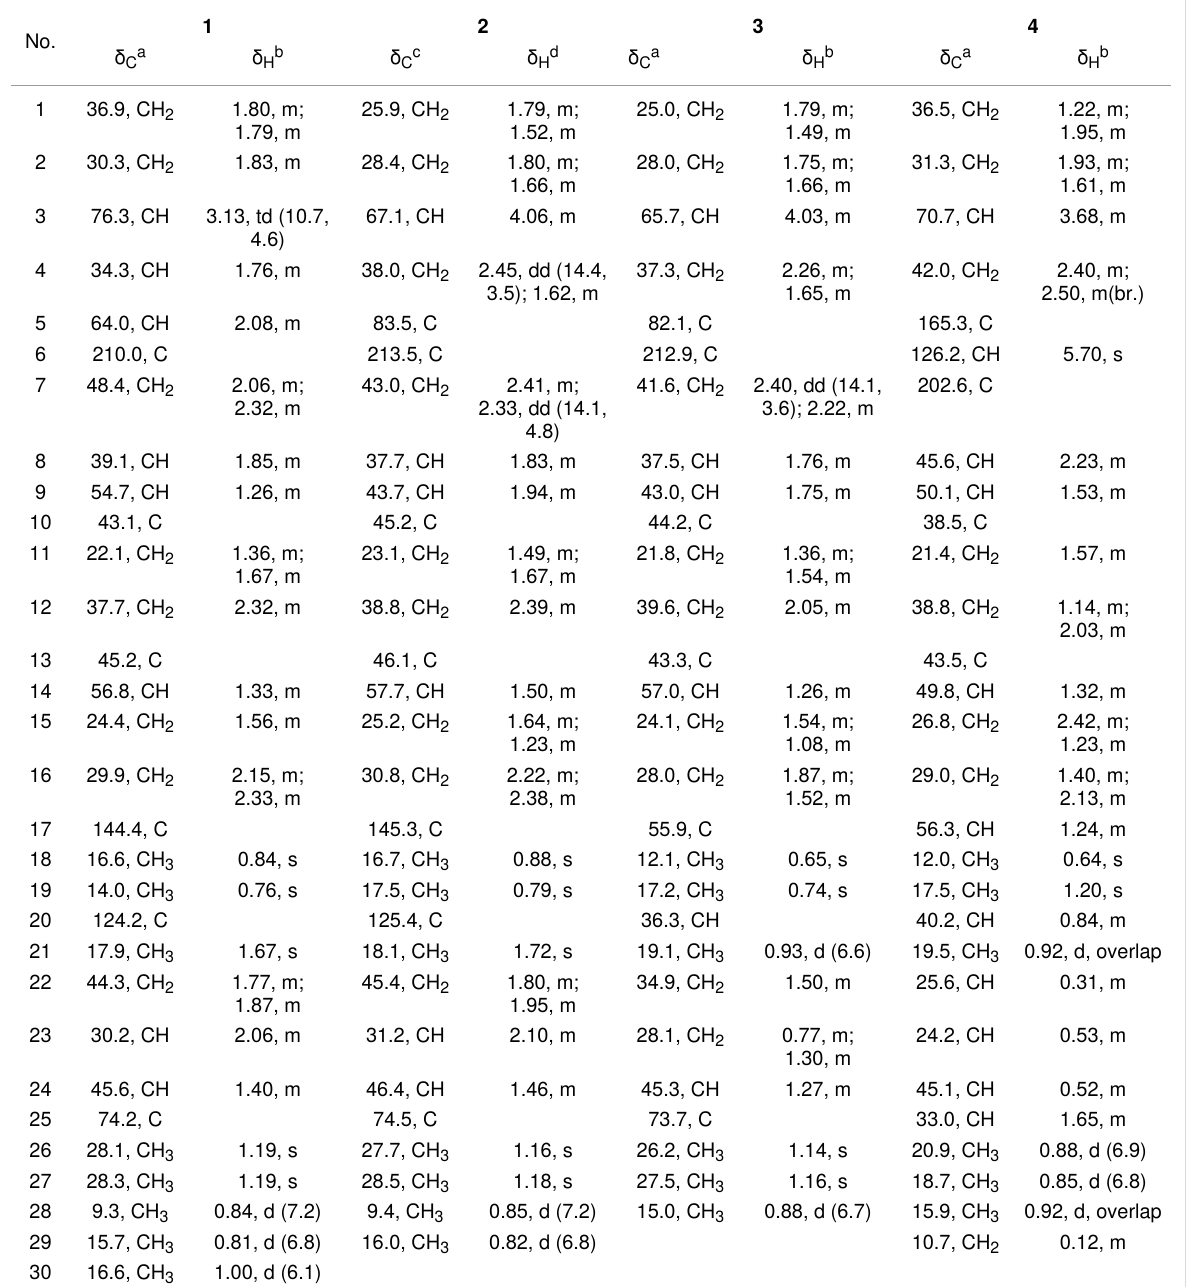
Table 1: 1 H and 13 C NMR data of compounds 1 – 4 ( δ in ppm and J in